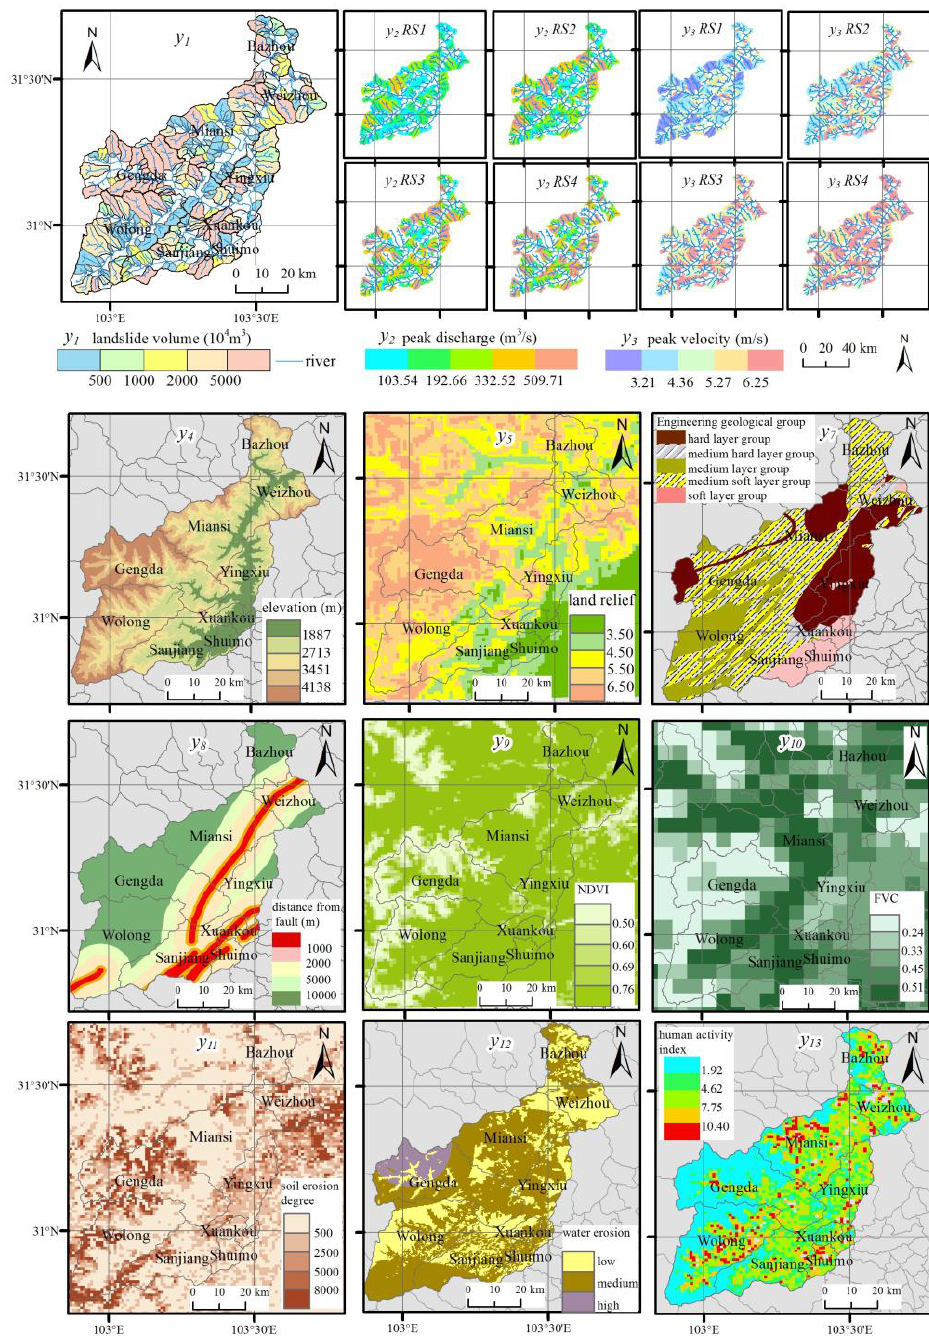
Figure 3. Classification of the hazard factors of debris flows. In the sub-figure “engineering ecological group”, the hard layer group includes granite, gabbro, breccia, and diorite. The medium-hard layer group mainly consists of dolomite and marble. The medium layer group includes slate, limestone, and clasolite. The medium-soft layer group consists of tuff, phyllite, marl, and siltstone. The soft layer group includes mudstone and shale.